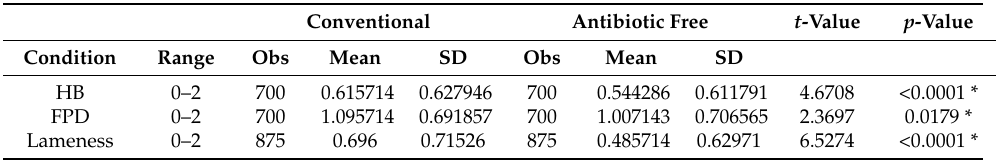
Table 2. Comparison of the average scores obtained for hock burns (HB), foot pad dermatitis (FDB) and lameness evaluations between the two farming systems (conventional vs. antibiotic free), including the range of scores assigned (0–2), the number of observations (Obs), the mean scores with standard deviations (SD) and the results of statistical analysis ( t - and p -values). The presence of a statistically significant difference ( p < 0.05) is indicated with an asterisk